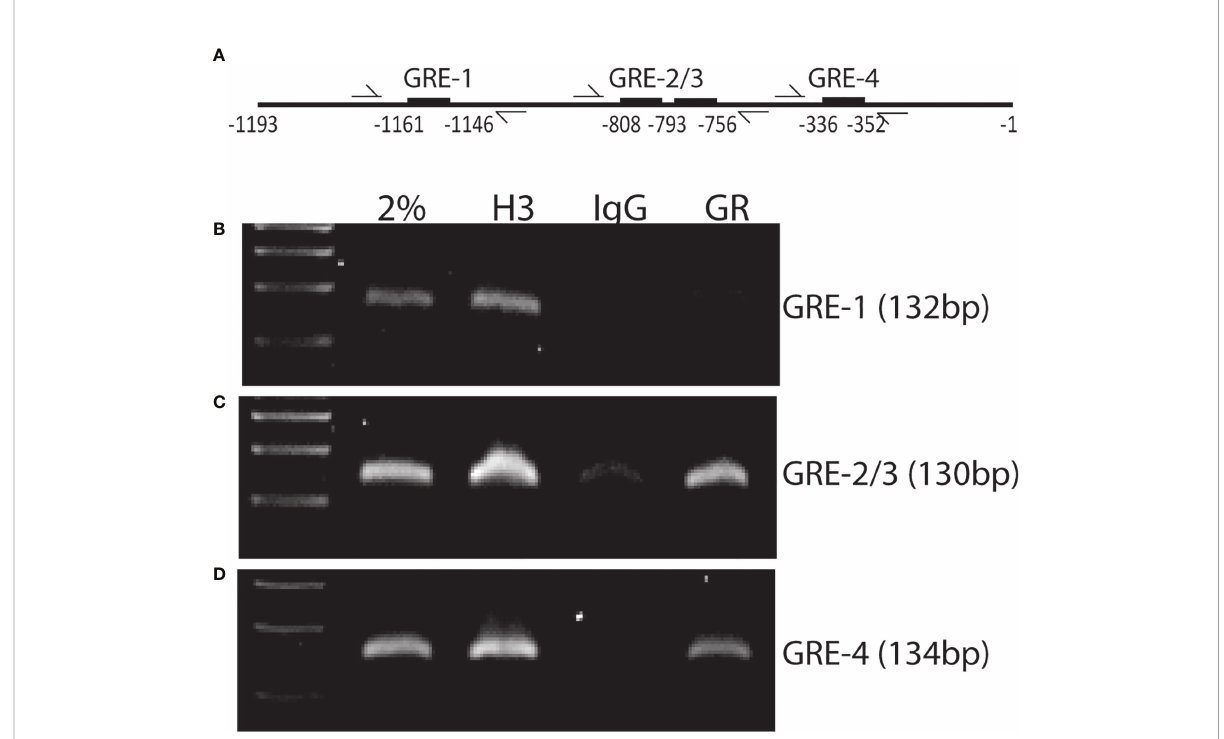
FIGURE 6 ChIP assay showing GR binding to Xist promoter region. (A) Schematic diagram of the approximate locations of GREs and fl anking primers used in PCR reactions. (B – D) agarose gel images showing PCR products ampli fi ed from anti-GR antibody precipitated DNA fragments and primer pairs fl anking the indicated GREs. Input: 2% sonicated DNA; H3: Anti-histone H3 mAb (positive control); IgG: normal rabbit IgG (negative control); GR: Anti-GR mAb. Experiment was performed 3 times with similar results. Shown is the results from one representative